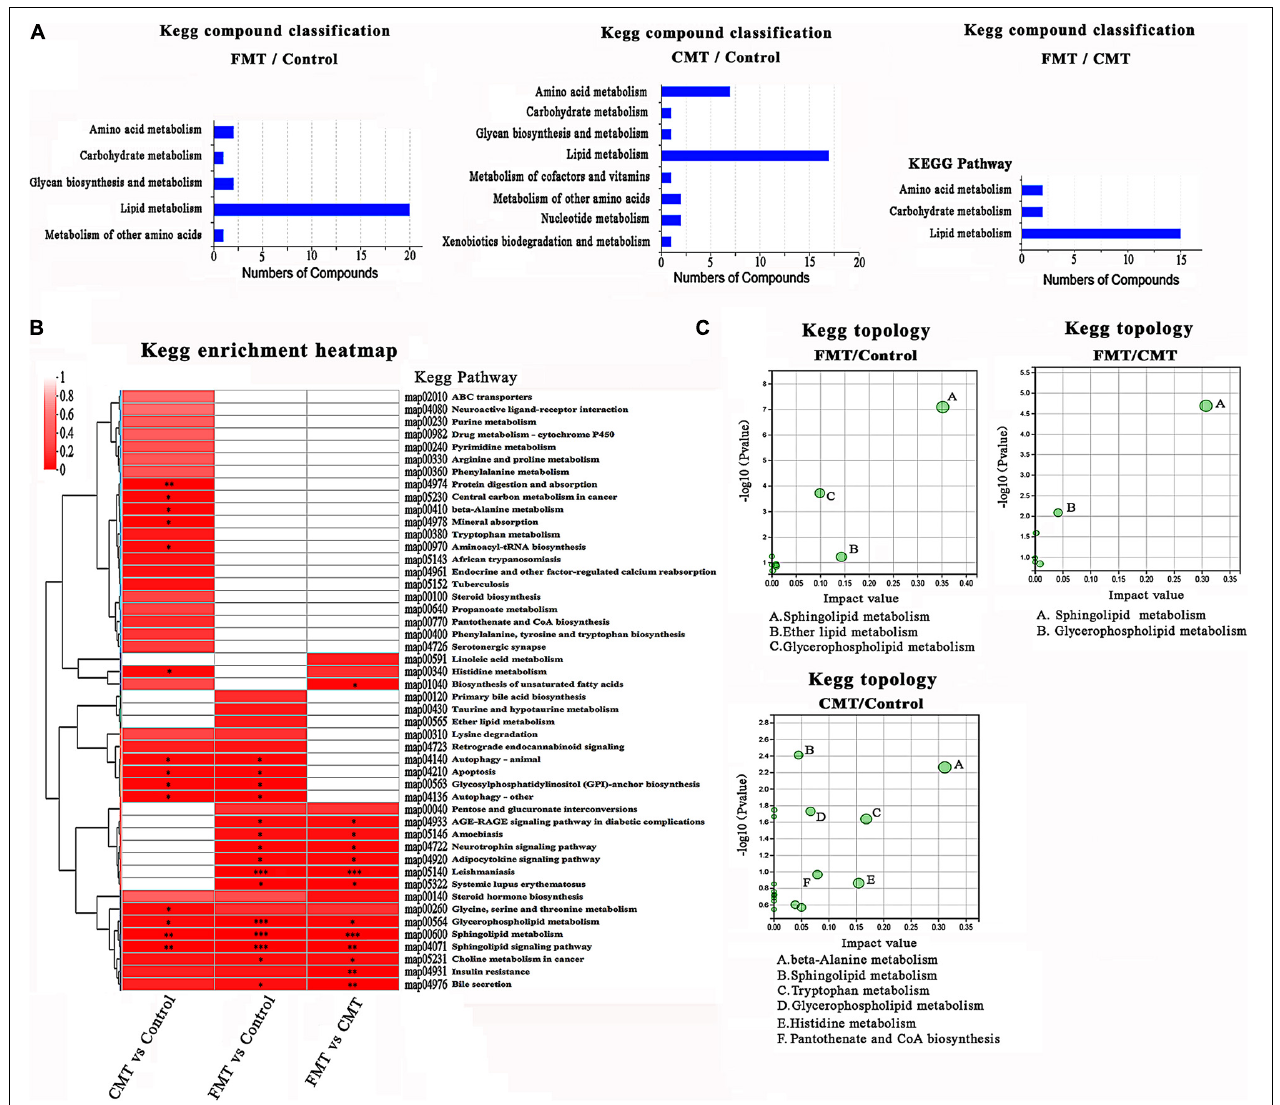
FIGURE 8 | KEGG enrichment analysis of different expressed metabolites. (A) KEGG pathway analysis based on the differentially expressed metabolites in the different piglets. (B) Clustered heat map of enriched KEGG pathway in the three comparisons. (C) KEGG topology analysis of the differentially expressed metabolites in the different